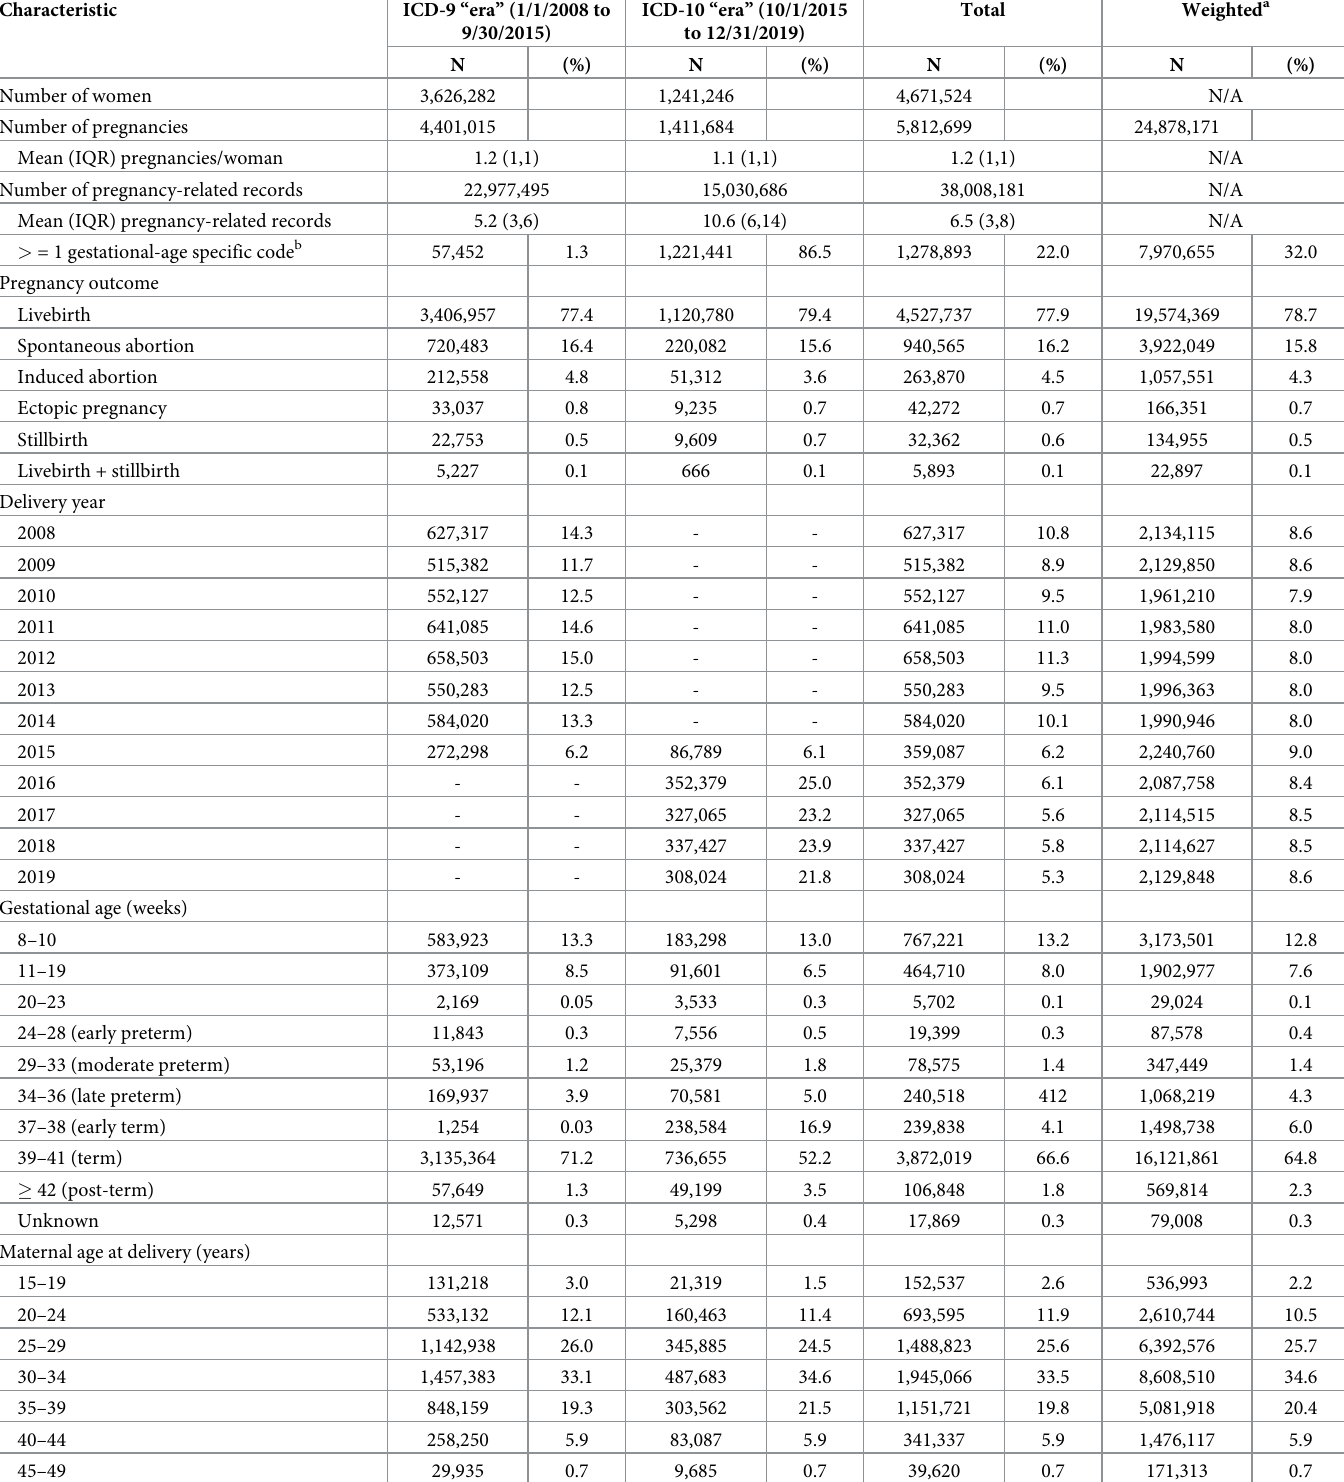
Table 2. Characteristics of pregnancy cohort overall and by international statistical classification of diseases clinical modification and procedure coding systems (ICD) era MarketScan commercial data, 2008–2019 (N = 5,812,699 pregnancies).